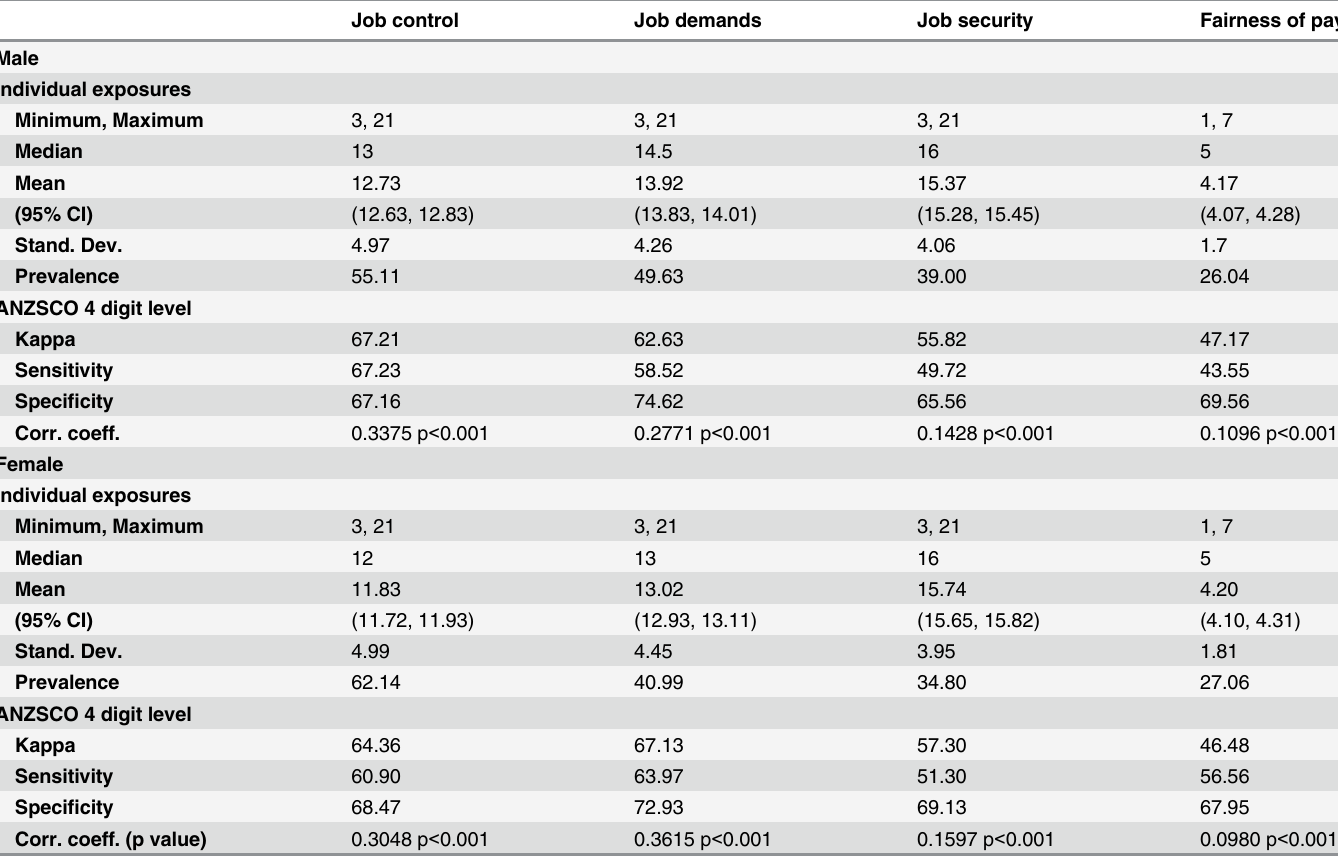
Table 2. Median, mean scores, and prevalence for individual exposures, kappa statistics, sensitivity, specificity, and correlations between individ- ual and JEM measures of psychosocial job stressors at the four-digit ANZSCO level, measured at the time of an individuals ’ first entry into the HILDA survey (people =